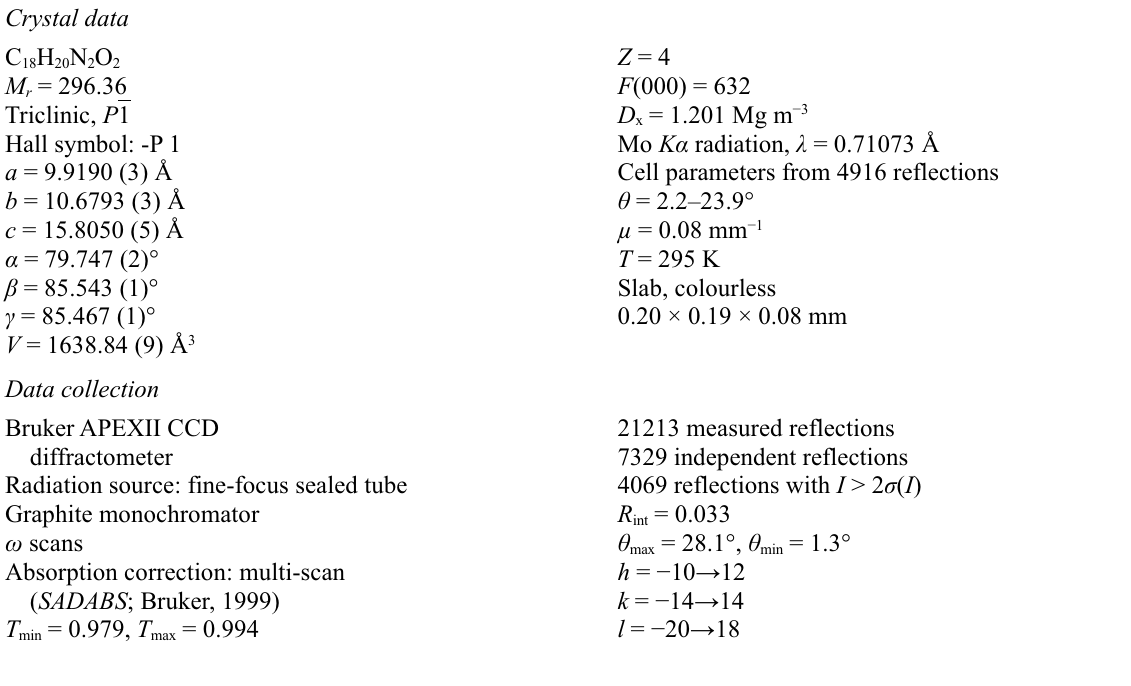
The molecular structure of (I); displacement ellipsoids for the non-hydrogen atoms are drawn with 30% probability. N